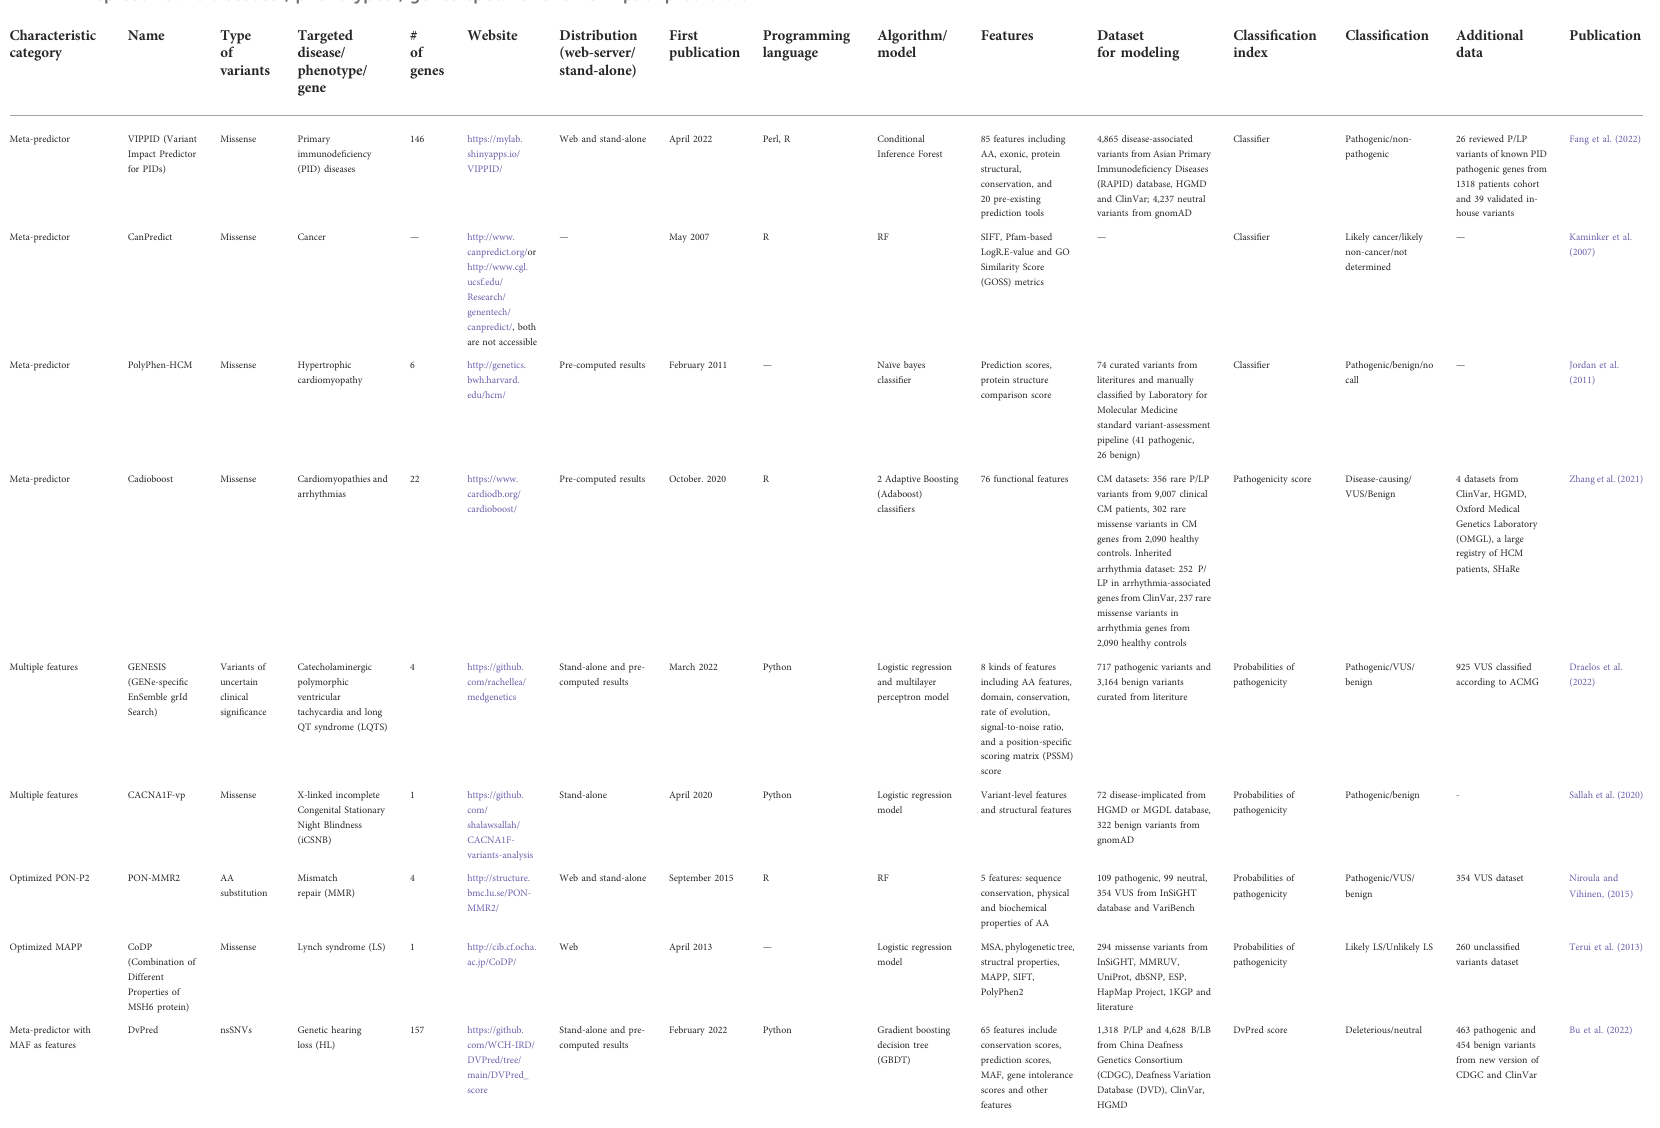
TABLE 2 Representative diseases-, phenotypes-, genes-speci fi c variants impact predictors. Characteristic